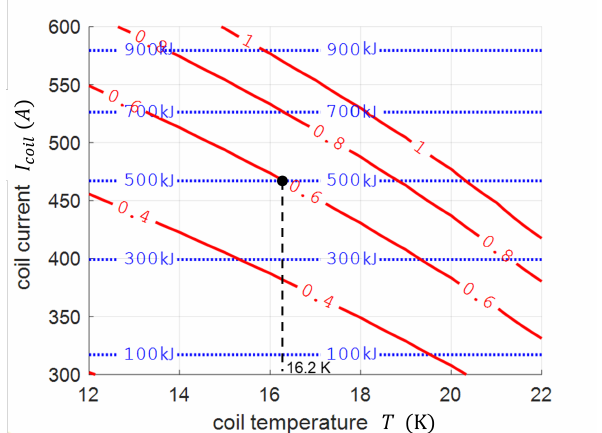
Figure 2. Performance of the coil as a function of the operating temperature and current. Red lines represent the loci of points with a constant I / I c ratio. Dotted horizontal lines represent the deliverable energy corresponding to the operating